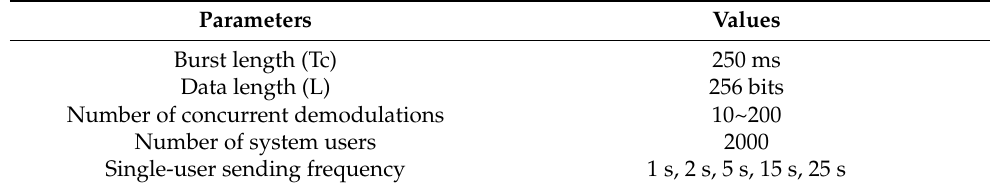
Table 2. Simulation parameters of SSA in the scenario of beam-hopping low-orbit satellite IoT.